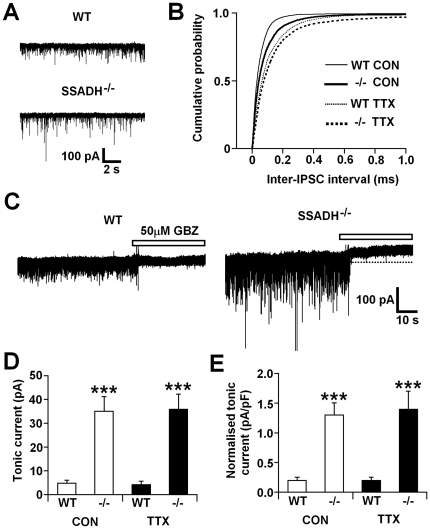
Increased tonic GABA current and IPSC frequency in layer V cortical neurons in SSADH−/− mice.A, representative current traces from layer 5/6 pyramidal neurons of wild-type (WT, top) and SSADH−/− (bottom) mice showing the difference in spontaneous IPSC amplitude between the two genotypes. B, cumulative probability plot showing the distribution of inter-IPSC intervals under control conditions (Con) (WT, thin line, 9356 inter-IPSC intervals; SSADH−/−, thick line, 6245 inter-IPSC intervals) and in the presence of 0.5 µM TTX (WT, thin dashed line, 3430 inter-IPSC intervals; SSADH−/−, thick dashed line, 2977 inter-IPSC intervals). C, representative current traces from layer 5/6 pyramidal neurons of WT (left) and SSADH−/− (right) mice showing the difference in tonic current amplitude between the two genotypes. Note that a tonic current is not apparent in the neuron from the WT animal. Dotted lines represent the initial baseline current prior to the focal application of 50 µM GBZ (white bar). D, graph comparing absolute tonic current amplitude in WT and SSADH−/− mice under control conditions (Con, white columns), and in the presence of TTX (black columns). E, graph comparing normalized tonic current amplitude between WT and SSADH−/− mice under control conditions (Con) and in the presence of TTX. D and E, *** P<0.001 WT vs. SSADH−/−, Student's unpaired t-test.